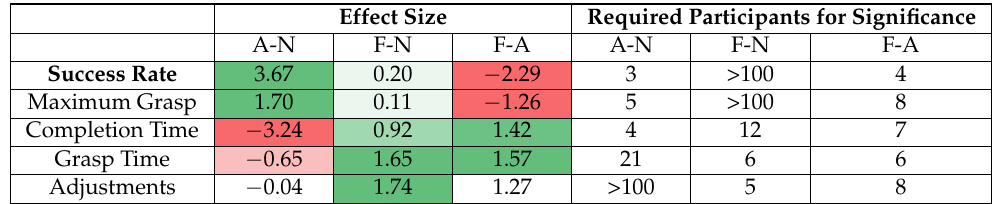
Table 3. Between-participant power analysis summary (green shading represents a positive value, red shading represents a negative value, strength of shading represents the magnitude of